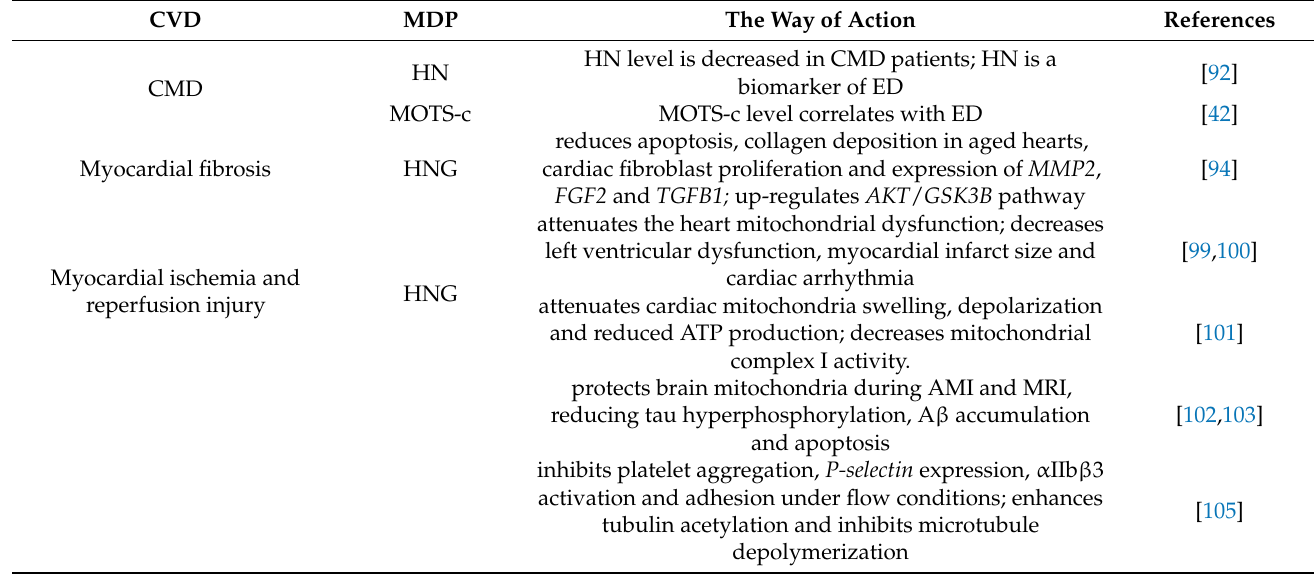
Table 2. Identified connections between CVDs and